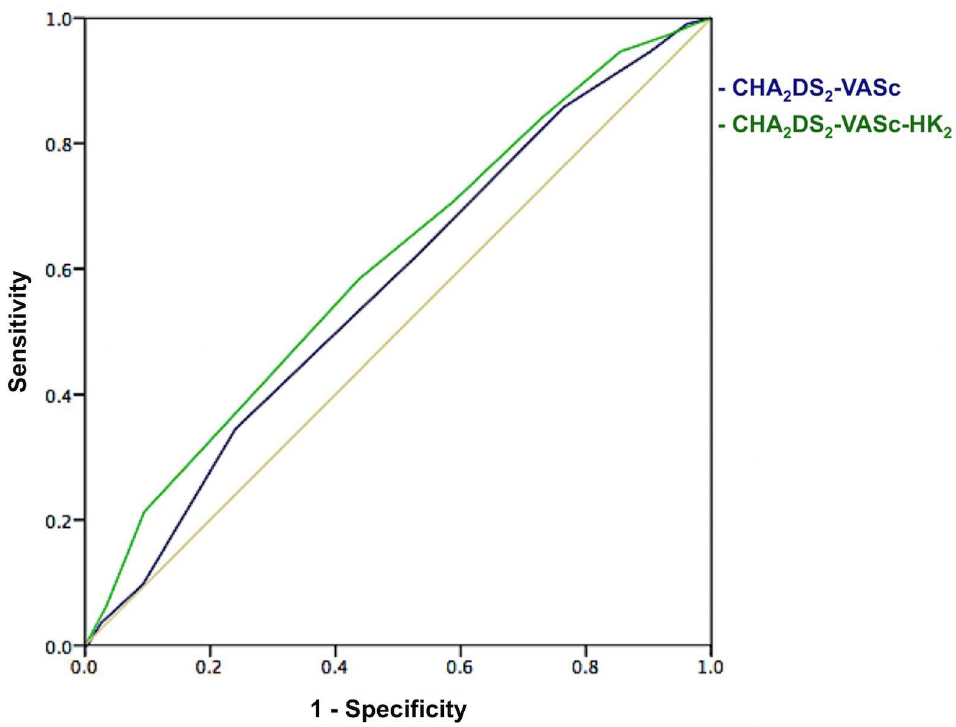
Fig 3. Receiver-Operating Characteristics curves for the CHA 2 DS 2 -VASc and the CHA 2 DS 2 -VASc-HK 2 score to predict thromboembolic events among heart failure patients in sinus rhythm. The area under the curve for the CHA 2 DS 2 -VASc score was 0.57 (95% CI 0.54–0.59) and that for the CHA 2 DS 2 -VASc-HK 2 score was 0.61 (95% CI 0.58–0.63). A significantimprovement in the area under the curve was